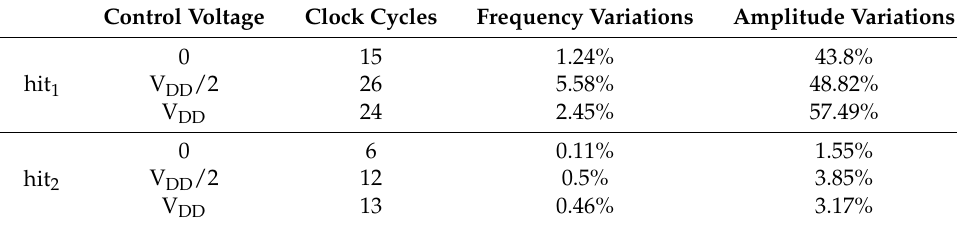
Figure 6. Differential output amplitude of the oscillator vs. time hit by an ionising particle plotted for the control voltage value equal to V DD . Two different sets of values were used: ionising particles with 60 and 5 MeV·cm 2 /mg at 10 and 15 ns, respectively. Table 1. Frequency and amplitude variations due to